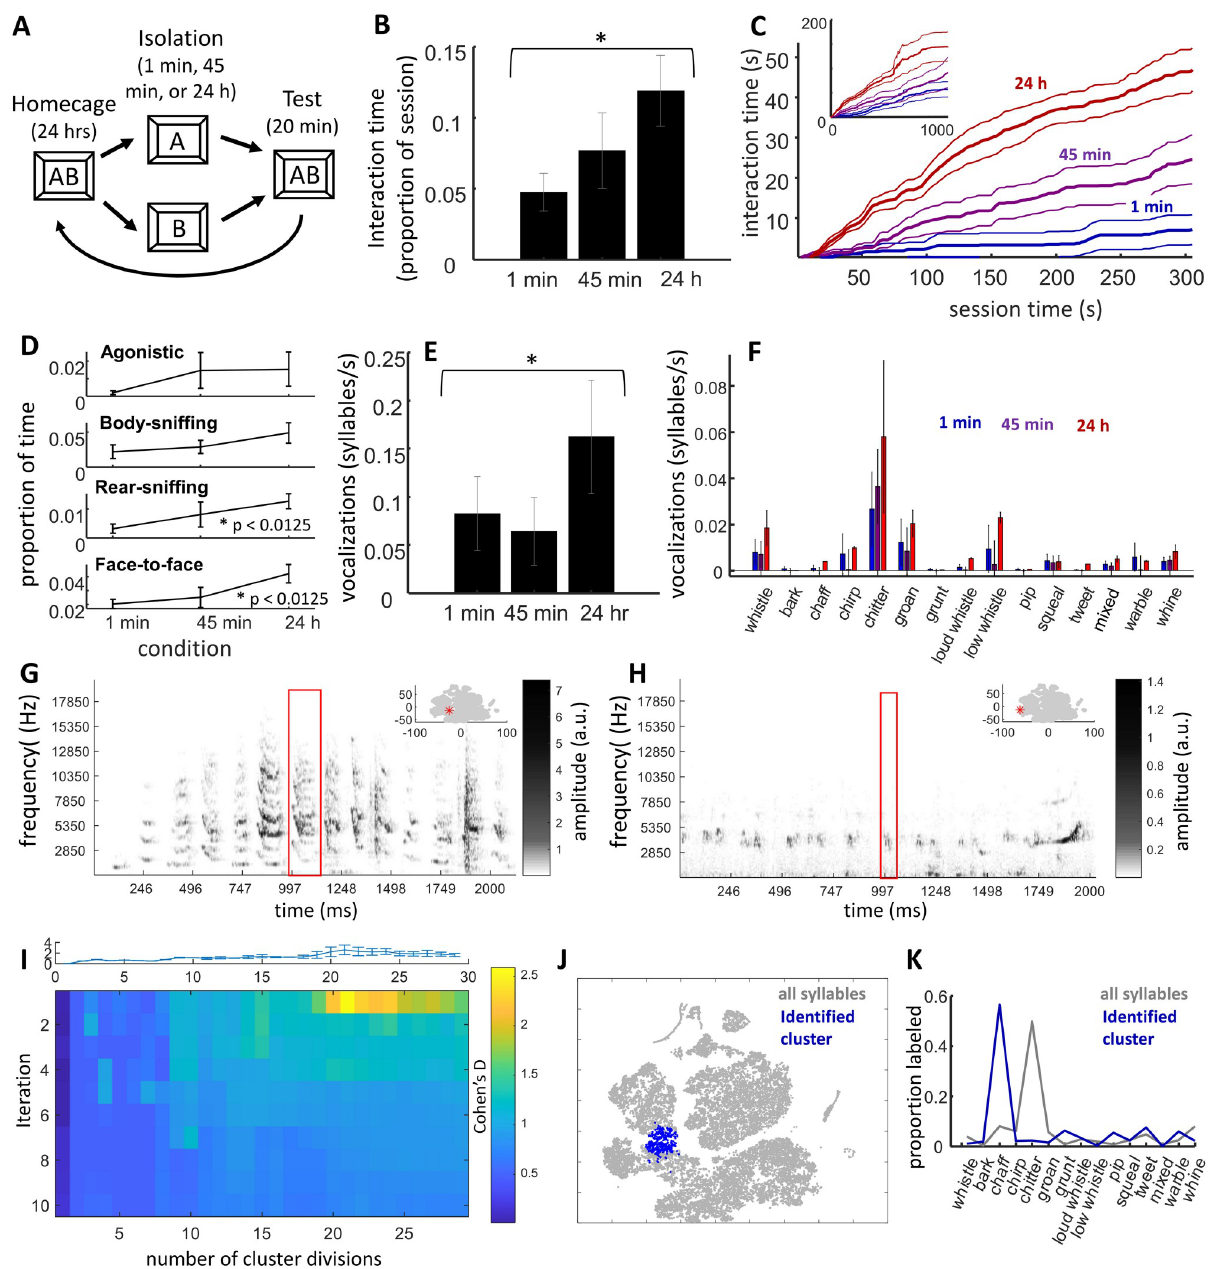
Fig 1. Effects of social isolation time on reunion behavior. A) Illustration of experimental design. Degus (n = 9 dyads) were separated from cagemates for 1 min, 45 min, or 24 hours then interactions were examined in a testing chamber. After being reunited for 24 hours the process was repeated. B) Proportion of time engaged in physical interactions (y axis) increased with the amount of preceding time of isolation (x-axis). C) Cumulative distributions of physical interactions over session time. Thicker lines are means, thin lines s.e.m. Higher levels of interaction in the 24 hr condition were seen within the first minute and remained high for the first 5 minutes. Inset shows full, 20 min of session time; although interaction time in the 24 hr condition remained higher, interactions in the 1 and 45 min conditions were more distributed across session time. D) Line graphs of interaction time across types of physical interaction; no interaction between type and condition was observed. E) Vocalization rates (y-axis) significantly increased across conditions (x-axis). F) Vocalization rates were consistently higher in the 24 hr condition across the 15 vocalization categories tested. G) Example spectrogram of a series of chaff and related syllables and H) chitter syllables. Low-frequency (below 400 Hz) noise is removed from plot. Red box in the center highlights a single syllable, inset in upper-right shows the t-SNE map used in panel J and S3 Fig, with a red asterisk marking where the central syllable landed within the projection. Syllables in both sequences may have come from one or both members of a dyad. I) Heatmap of identified syllable clusters with the strongest difference between the 24 hr and 1 min conditions, across k-means clusters repeated for 2–30 cluster divisions (columns), iterated after removing syllables from the best cluster (rows). Plot on top is an errorbar showing variance of the first (top-row) across 20 repetitions. The